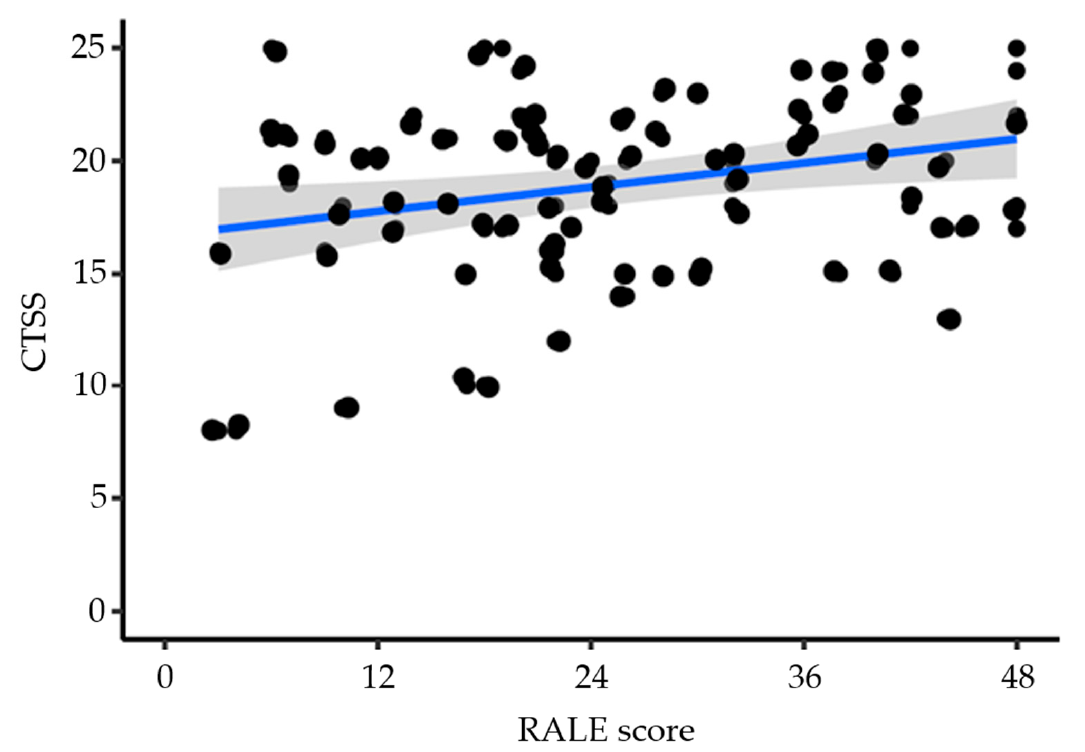
Figure 3. Scatterplot showing the correlation between the RALE score and the CTSS, with the linear regression estimation (in blue), and the 95%CI shown in shaded area. R 2 = 0.075; p = 0.012. Beta coefficient for RALE score: 0.08 [95%CI 0.02–0.16].